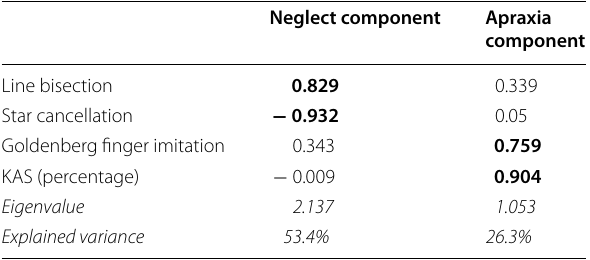
Table 3 Results of the principal component analysis (PCA) of the neglect and apraxia